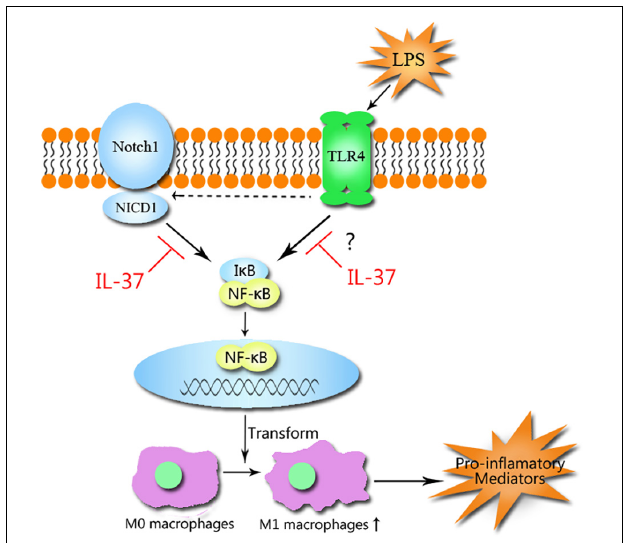
FIGURE 6 | The mechanism that IL-37 suppresses M1 macrophage polarization. IL-37 suppresses M1 macrophage polarization through the Notch1-NF- κ B axis pathways. The activation of Notch1 by TLR4 stimulation with LPS causes the generation of NICD1, which interacts with I κ B and results in the activation of NF- κ B, but the generation can be inhibited by IL-37. IL-37 prevents Notch1 and NF- κ B activation and thus attenuates M1 polarization and inhibits the inflammatory